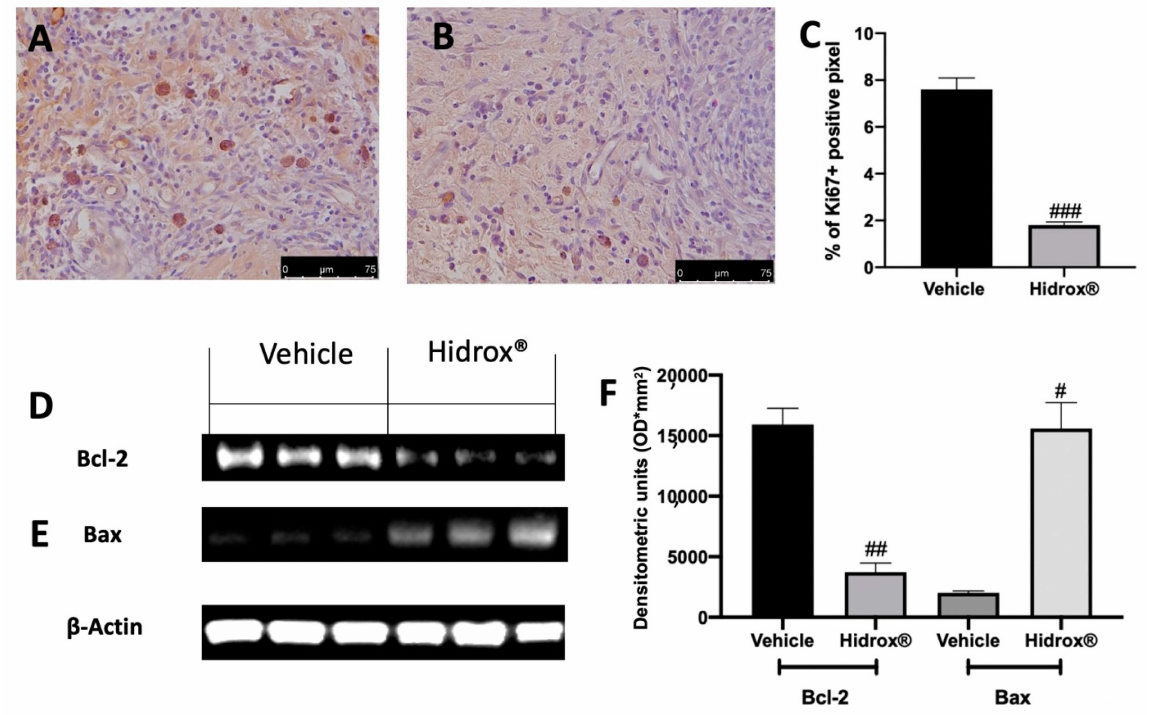
Figure 3. Hidrox ® administration reduced hyperproliferation and increased apoptosis endometriosis-induced: immunohis- tochemical analysis of Ki67: vehicle ( A ), Hidrox ® ( B ), graphical quantification of Ki67 expression ( C ), Western blot analysis of Bcl-2 ( D ), Bax ( E ), densitometric analysis ( F ). For the analyses, n = 5 animals from each group were employed. A p -value of less than 0.05 was considered significant. # p < 0.05 vs. vehicle, ## p < 0.01 vs. vehicle, ### p < 0.001 vs.